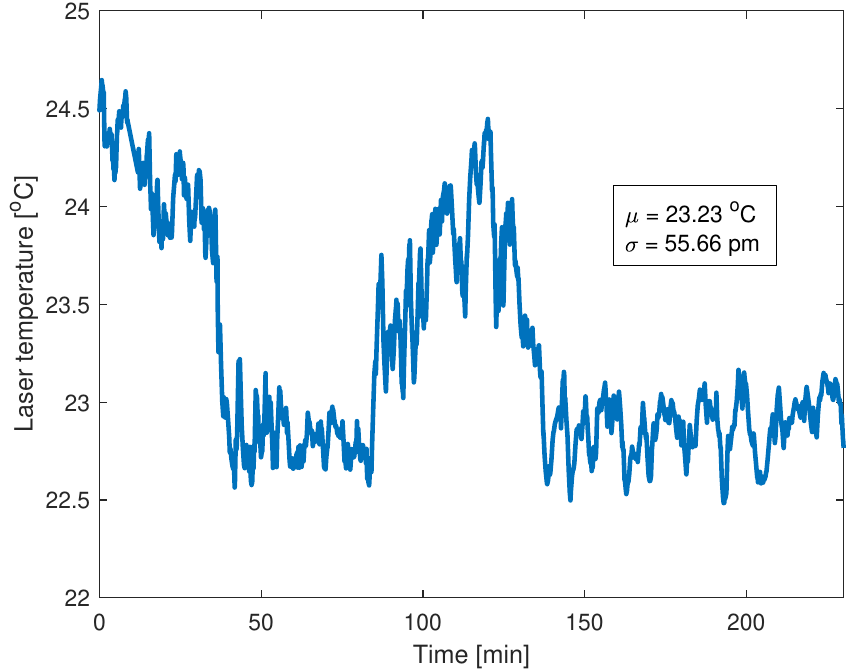
Figure 10. VCSEL-HCG laser temperature measured with a built-in thermistor. The standard deviation of a temperature change is equal to 0.5457 ◦ C, which corresponds to 55.66 pm in output wavelength value